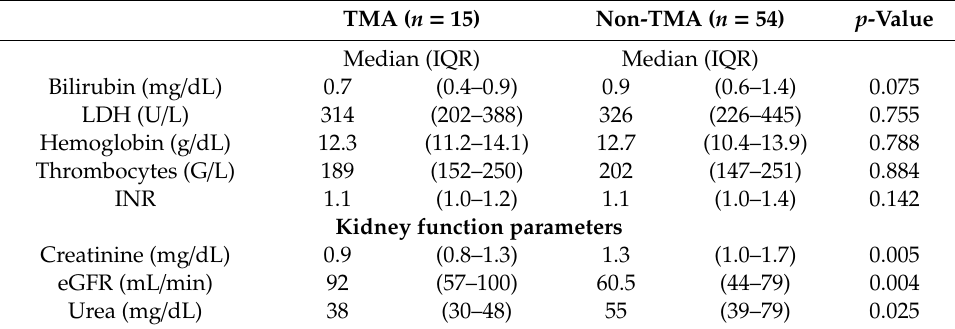
Table 2. Preoperative laboratory parameters.